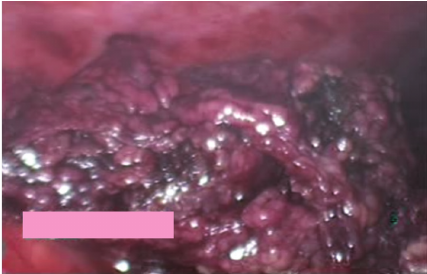
Figure 3: It shows a gangrenous omental mass on laparoscopic